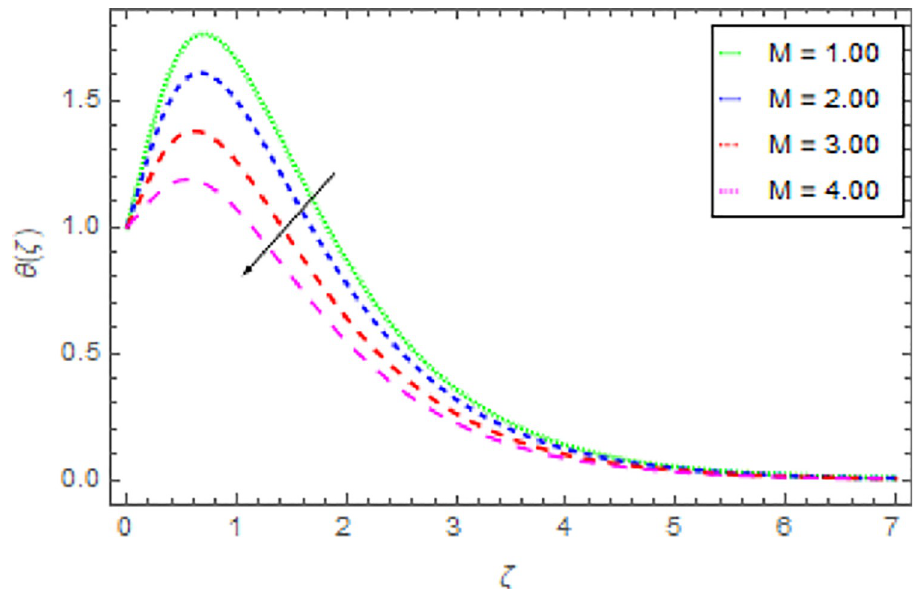
Fig 10. Deviation in nanofluid temperature against M when Pr = 1000, m = 0.10, n = 1.00, δ = 0.40, β = 1.00, Nr = 0.20 and ϕ = 0.01 to ϕ = 0.04.